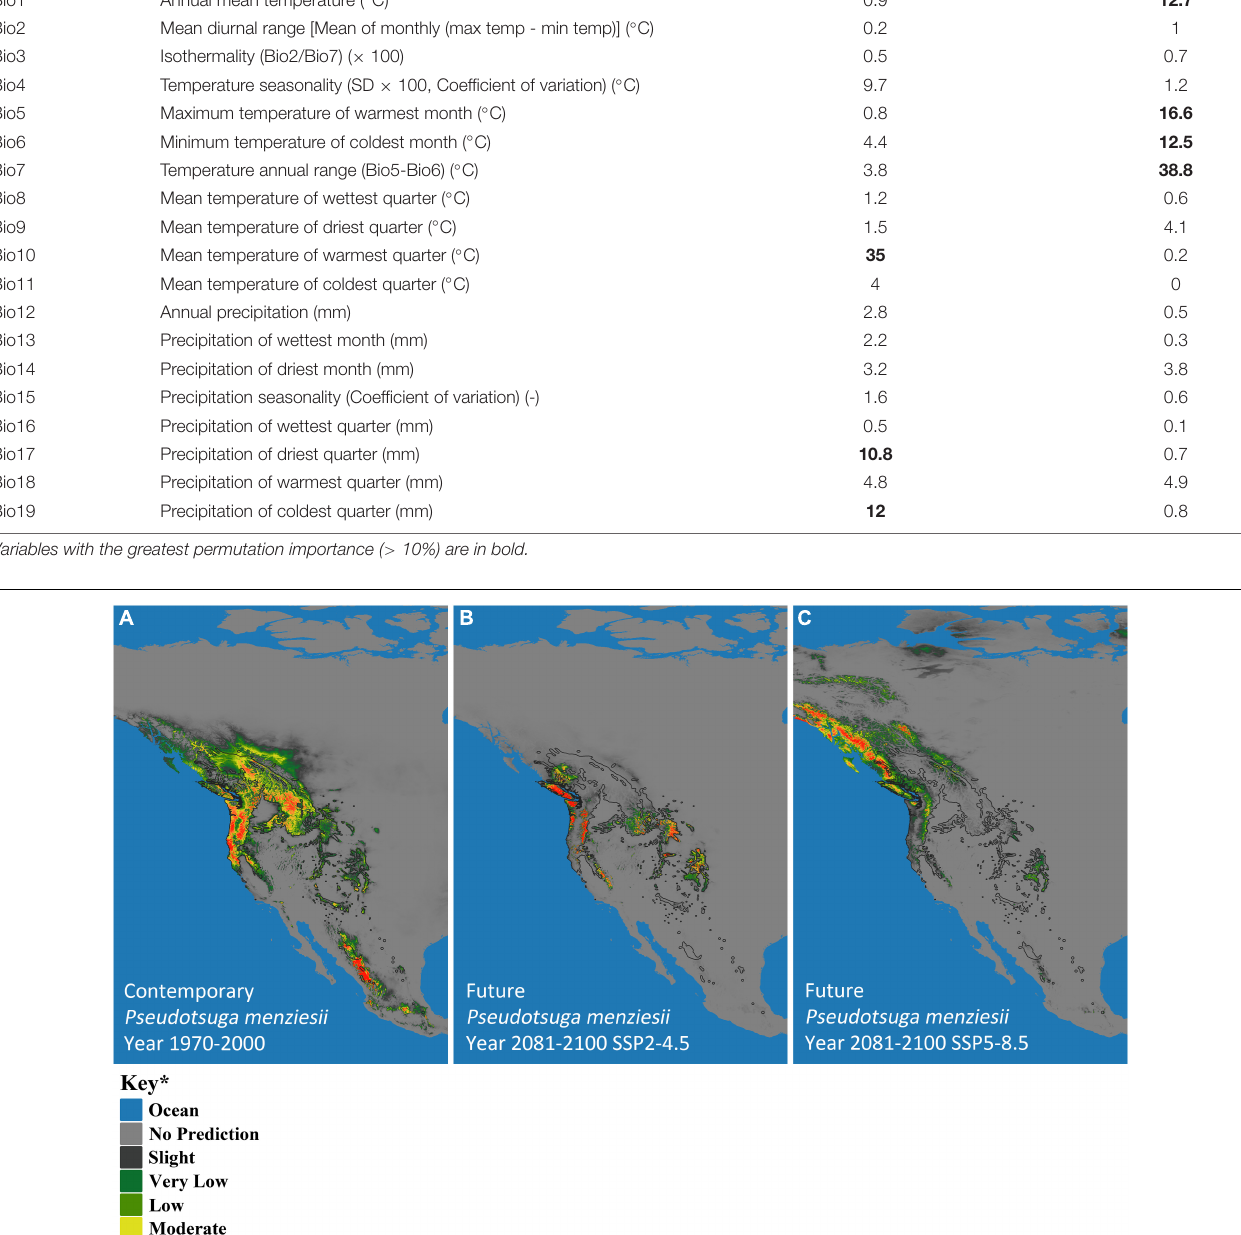
Frontiers in Forests and Global Change |